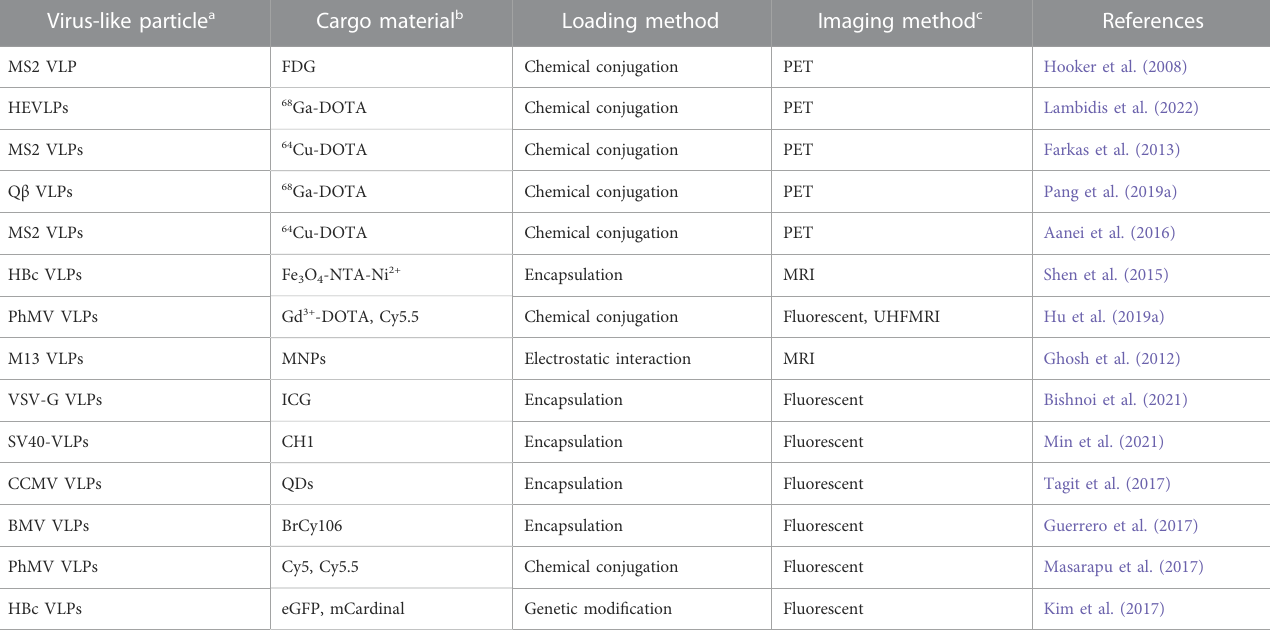
TABLE 2 Comparison of virus-like particles for bio-imaging. Virus-like particle a